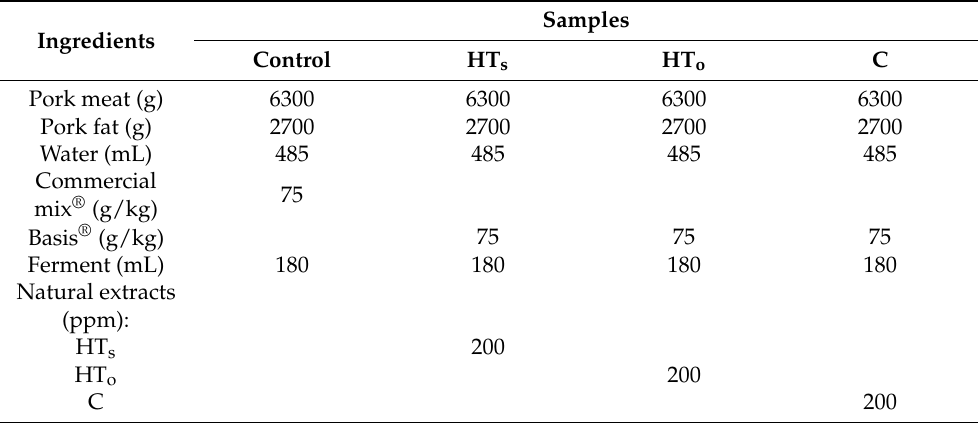
Table 1. Formulation of fuet